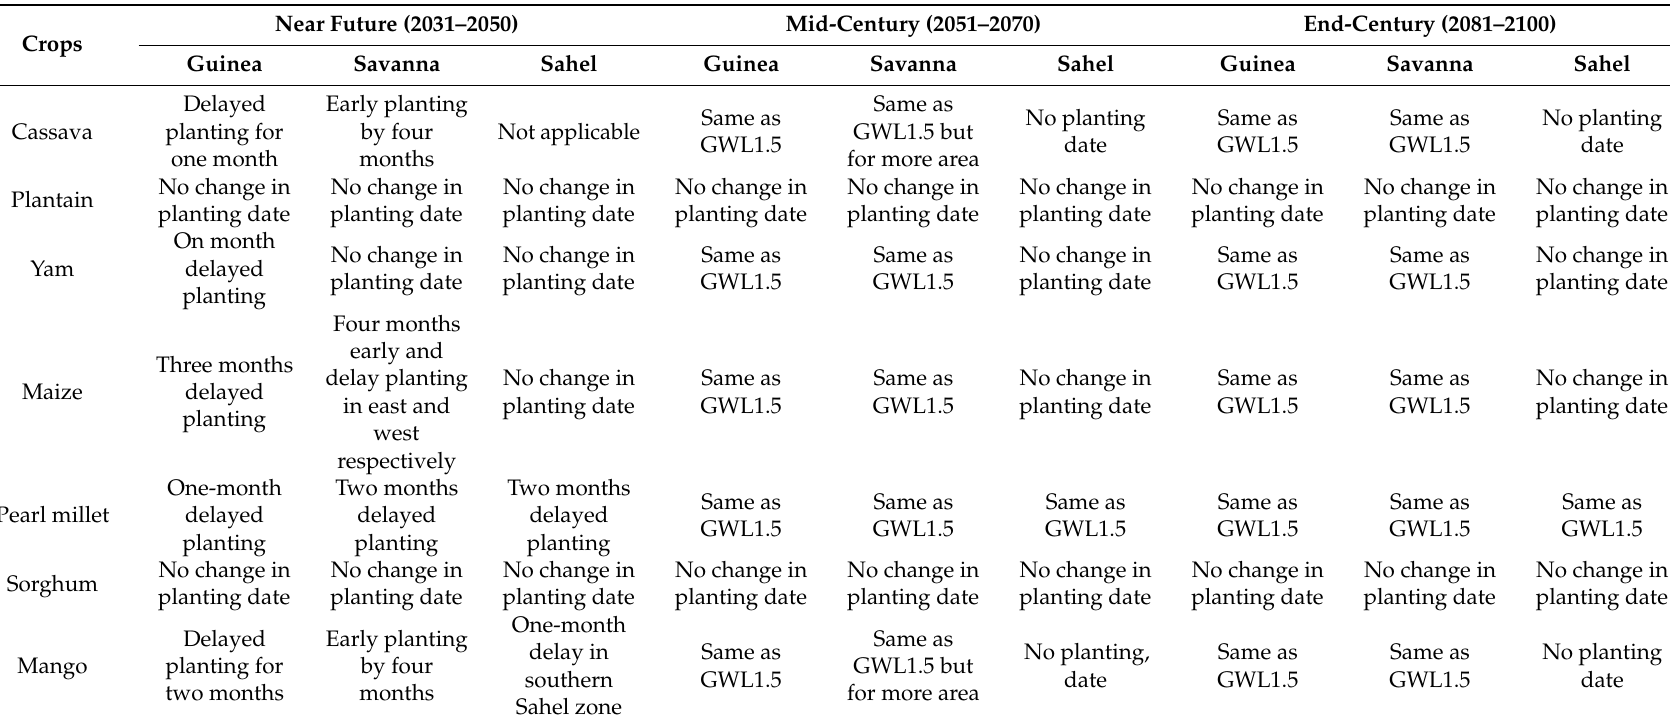
Table 3. Projected changes in time of planting (crop planting months) over West African AEZs at di ff erent global warming levels.